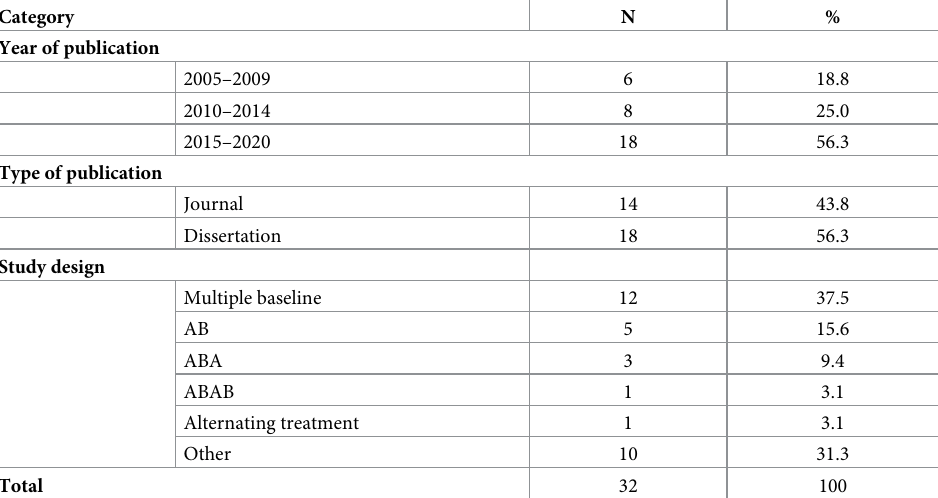
Table 3. General characteristics of the studies.